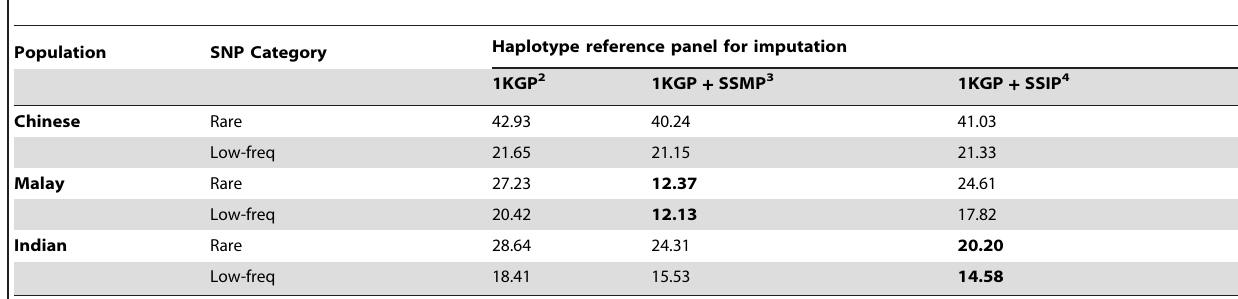
Table 2. Discordance (%) between imputed genotypes and actually observed minor allele genotypes 1 at rare and low-frequency SNPs on the exome chip but not in the